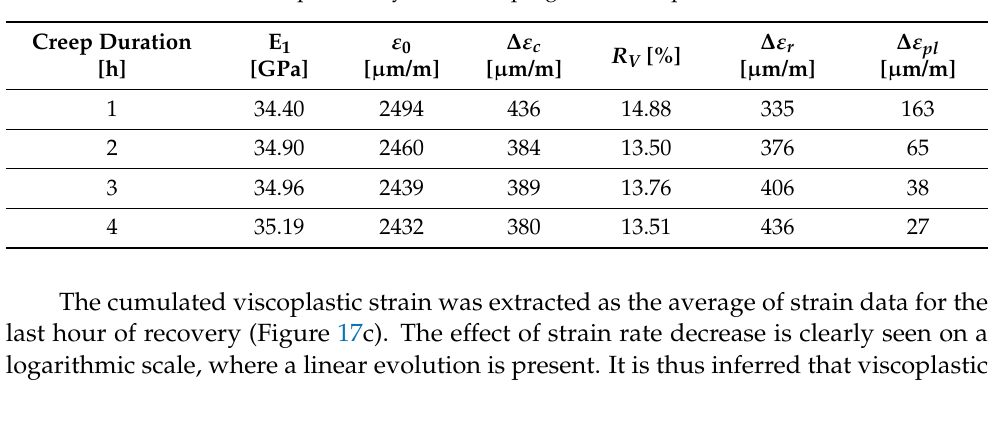
Figure 17. Analysis of the strain response during creep-recovery tests: ( a ) creep phases; ( b ) recovery phases; ( c ) plastic strain with respect to cumulated creep duration, in logarithmic time scale. Table 6. Strain data from creep-recovery tests with progressive creep duration.